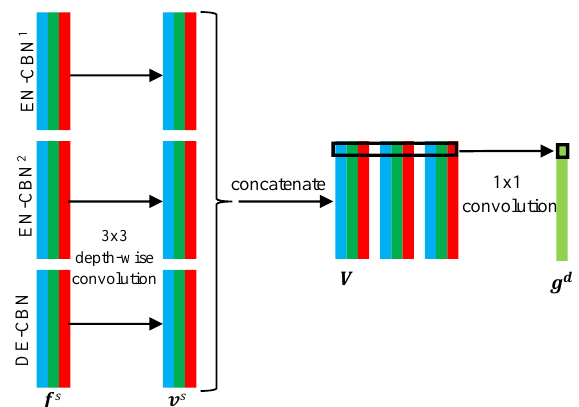
Figure 2: Skip-connections. EN-CBN 1 , EN-CBN 2 : feature maps delivered by all convolutional blocks of the encoder blocks N of the upper and lower branches in Fig. 1, respectively.